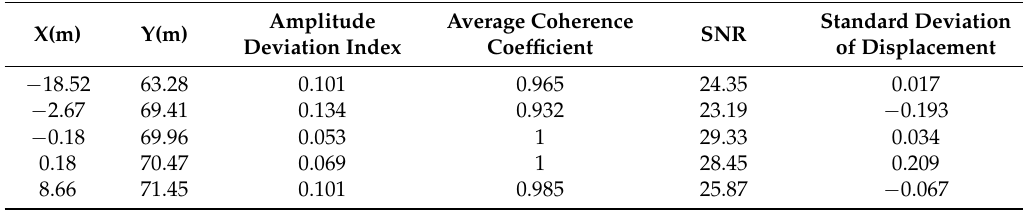
Figure 11. Result of selected PSC representative points. Table 3. Four parameters of PSC.